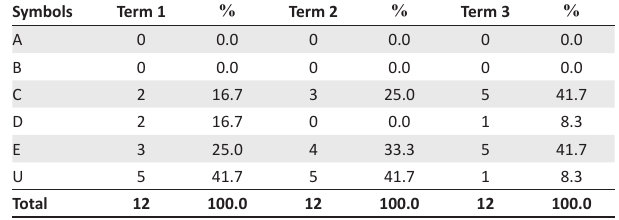
TABLE 4: English second language ( N = 12 ) . Symbols